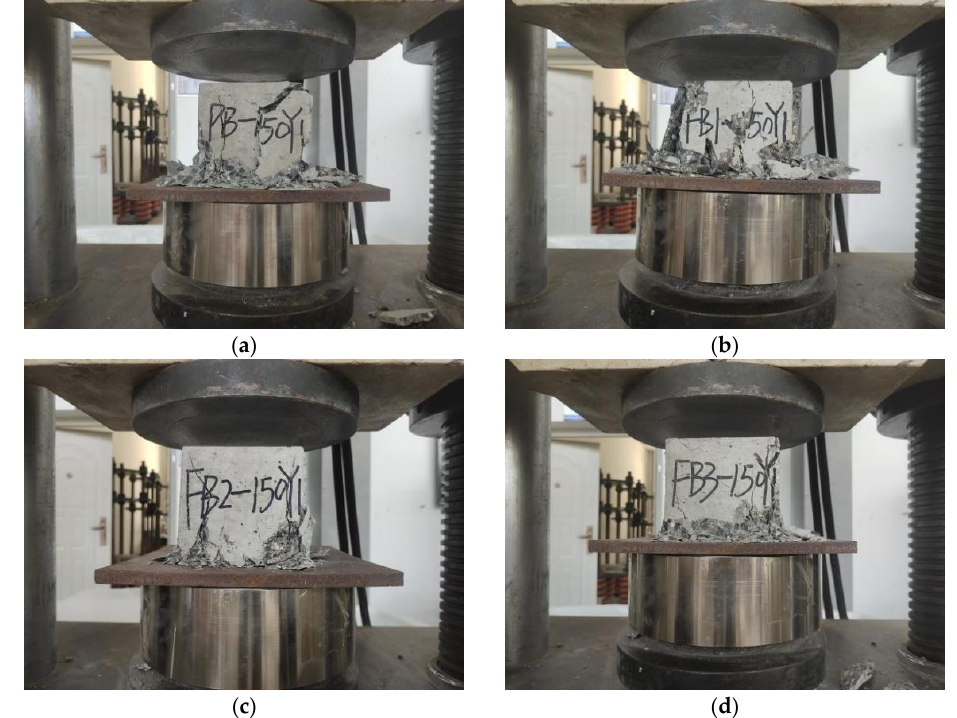
Figure 5. Specimen damage characteristics under pressure. ( a ) Specimen with 0% basalt fibers. ( b ) Specimen with 0.1% basalt fibers. ( c ) Specimen with 0.2% basalt fibers. ( d ) Specimen with 0.3% basalt fibers.